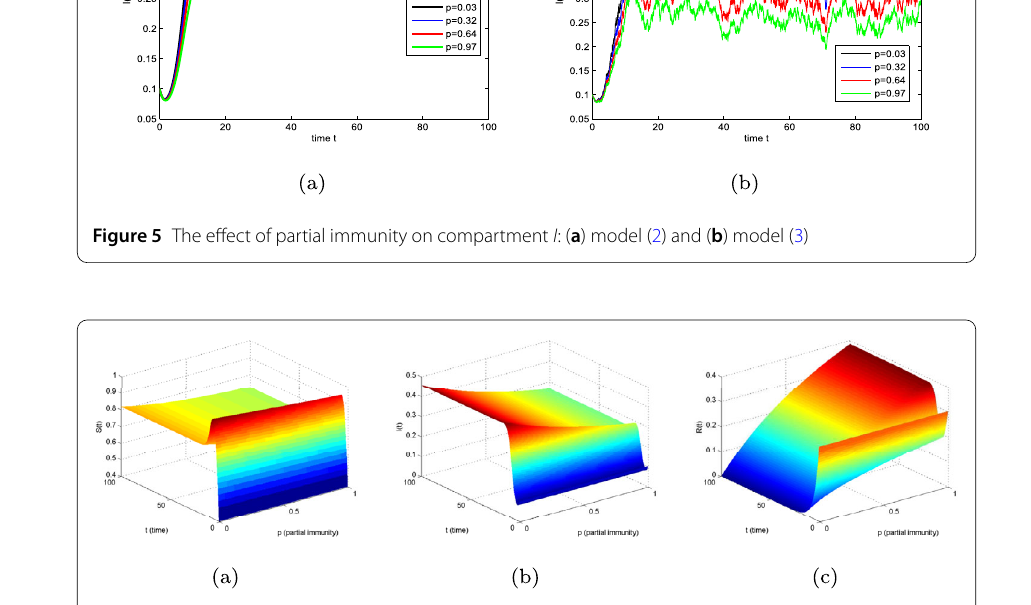
Figure 6 The effect of partial immunity p with respect to time t for compartments: ( a ) S , ( b ) I , and ( c ) R in model